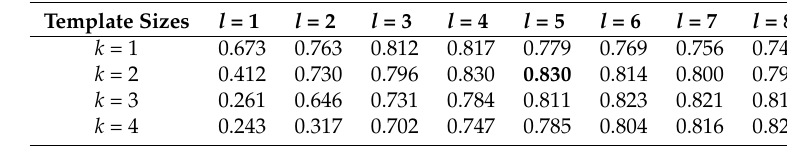
Table 2. Predictive performance of RPiRLS in terms of the accuracy on the RPI2662 training set over varying template